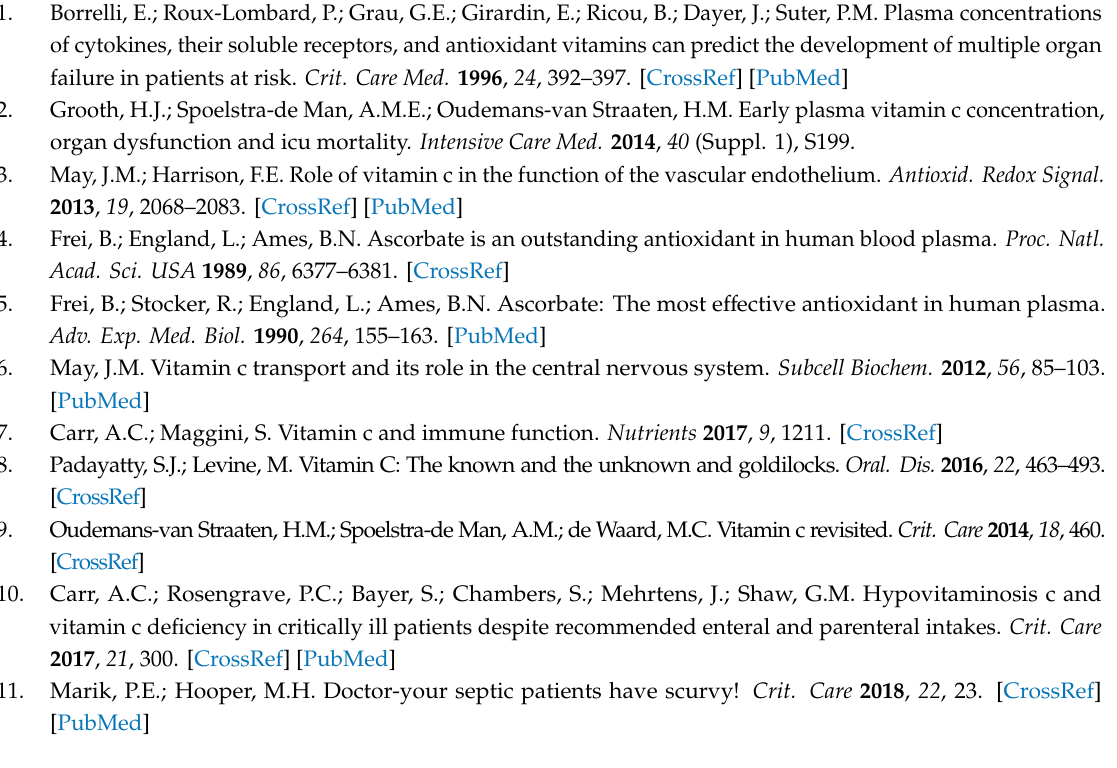
Table S1: Plasma vitamin C concentrations and plasma sORP / AOC at day 1 and 3 of ICU-admission; Table S2: Plasma vitamin C concentrations and plasma sORP / AOC during